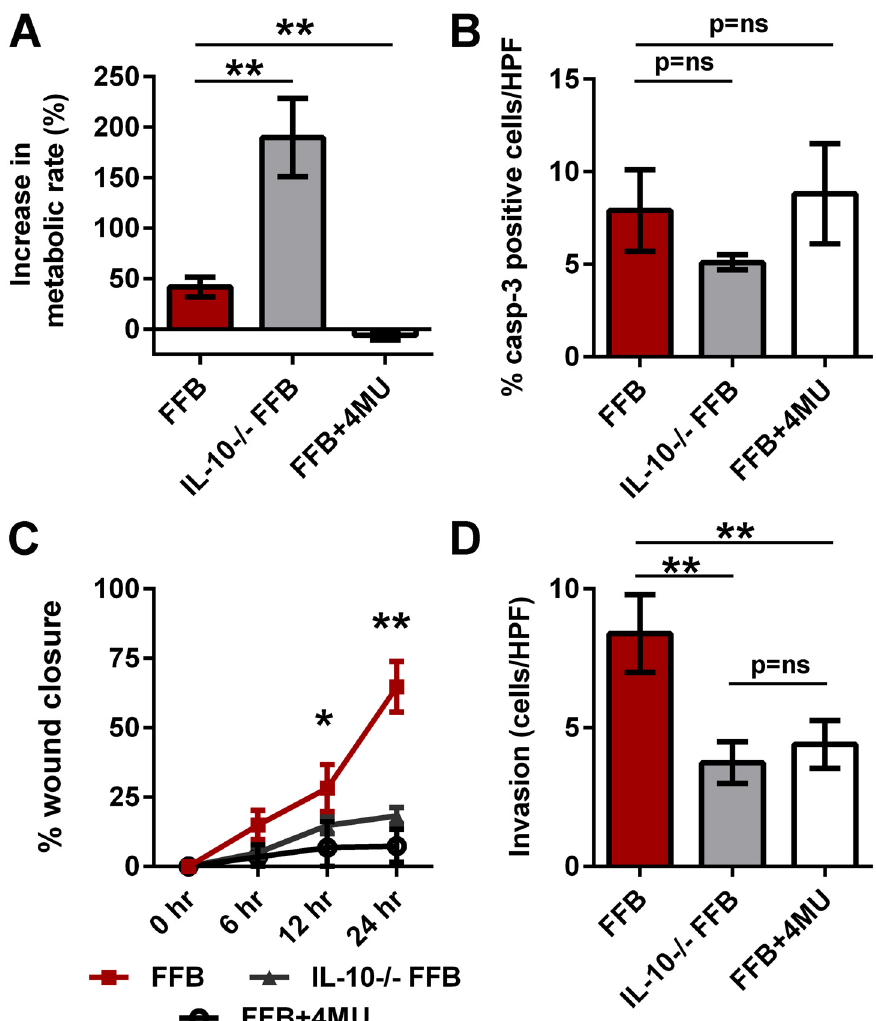
Fig 2. The role of IL-10 and hyaluronan in the functional profile of FFB. A) Rate of metabolism, B) apoptosis, C) migration and D) invasion were compared between FFB and IL-10 knockout FFB to determine if IL-10 is essential to the functional profile of the FFB, and between FFB and FFB in presence of 4-MU to determine if hyaluronan is essential to the functional profile of the FFB. Bar plots represent average ± SD. Asterisks denote statistically significant differences between the groups ( * p < 0.05, ** p < 0.01; Student ’ s t-test and ANOVA; n = 3 per group at similar passage number; each experiment was conducted in triplicates with cells from independent